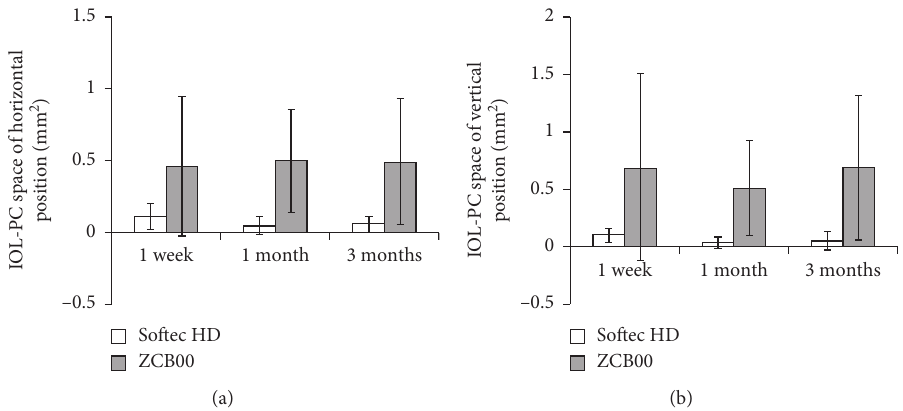
Figure 3: Postoperative IOL-PC space (SD) at different time points. Significant difference was found between the horizontal and vertical positions when compared at 1 week, 1 month, and 3 months postoperatively ( P < 0 . 05) except for the first week on the